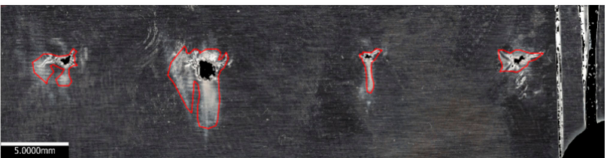
Figure 5. Scanned surfaces of the aluminum foils at the driving voltage of 190 V and at the diameter of 14 mm.